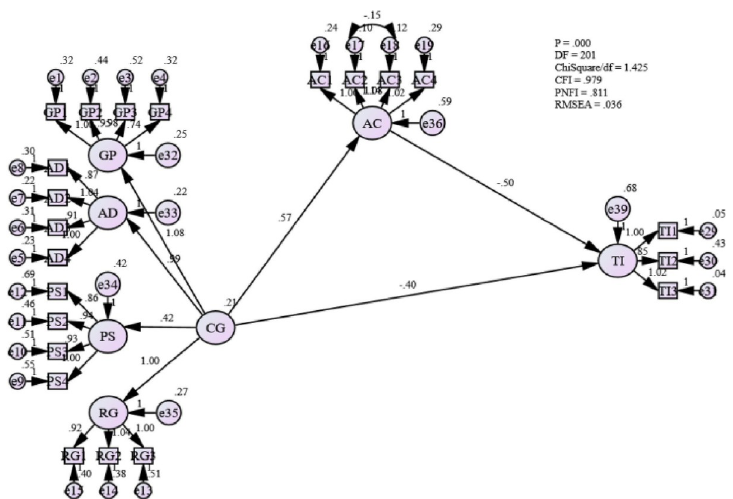
Fig 9. Mediating effect of affective commitment between career growth and turnover intentions.